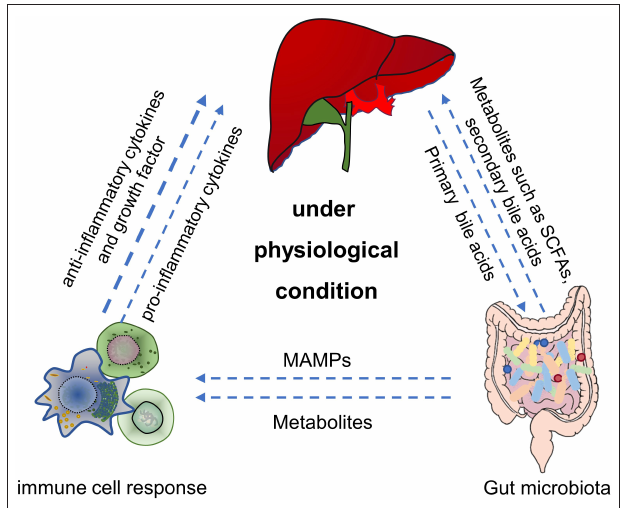
FIGURE 1 | The main role of gut microbiota in gut-liver-immune axis under physiological condition. First, by utilizing the nutrients and metabolic substrates (such as primary bile acids from liver), gut microbiota can produce various bioactive metabolites (such as acetate, propionate, butyrate, secondary bile acids, and amino acids) which were absorbed through the portal vein into the liver, to regulate hepatic function. Second, gut microbiota can also directly or indirectly establish and balance the hepatic immune response through metabolites, secondary bile acids and MAMPs. SCFAs, short chain fatty acids. MAMPs, microbial-related molecular patterns. Figure was partly adapted from Smart Servier Medical Art (https://smart.servier.com/), which is licensed under a Creative Common Attribution 3.0 Generic